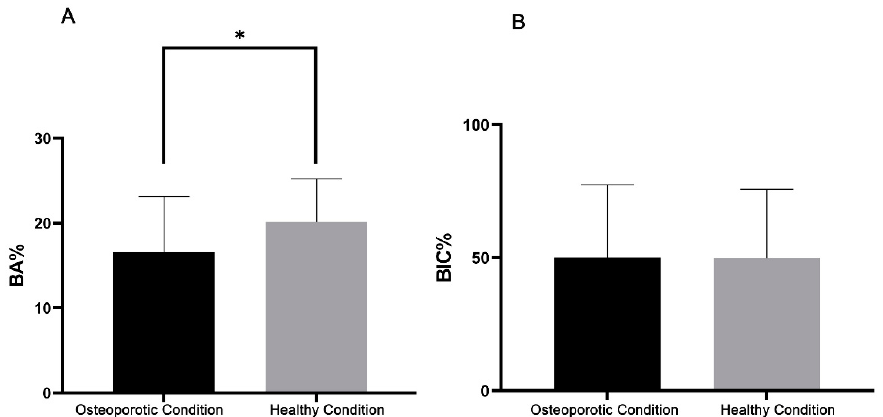
Figure 8. Bar-chart with mean and standard deviation, based on histomorphometric assessment, showing ( A ) bone area (BA%) and ( B ) bone-to-implant contact (BIC%) for the pooled data of the various drug treatment groups between osteoporotic and healthy conditions. ( * indicates p < 0.01).